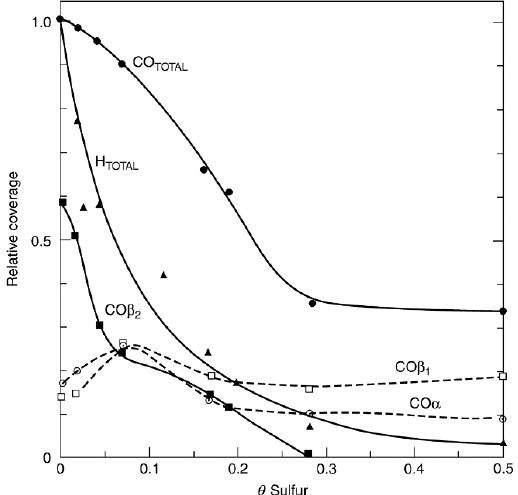
Figure 8. Area under thermal programmed desorption spectra for H 2 and the α, β 1 , β 2 , and total CO adsorption curves, as a function of sulfur precoverage. Reproduced from [44]. Copyright 1981, Elsevier.